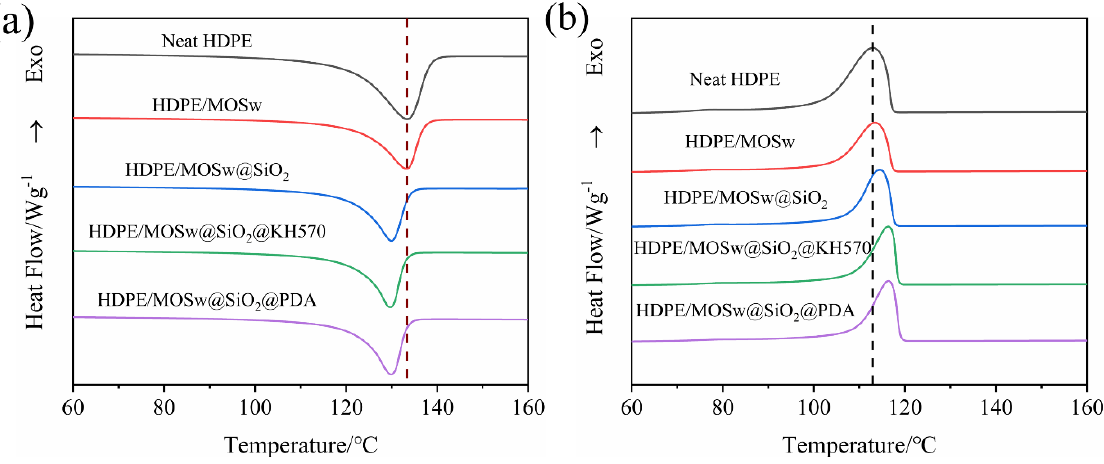
DSC curves of HDPE, HDPE/MOSw, HDPE/MOSw, HDPE/MOSw@SiO 2 ,